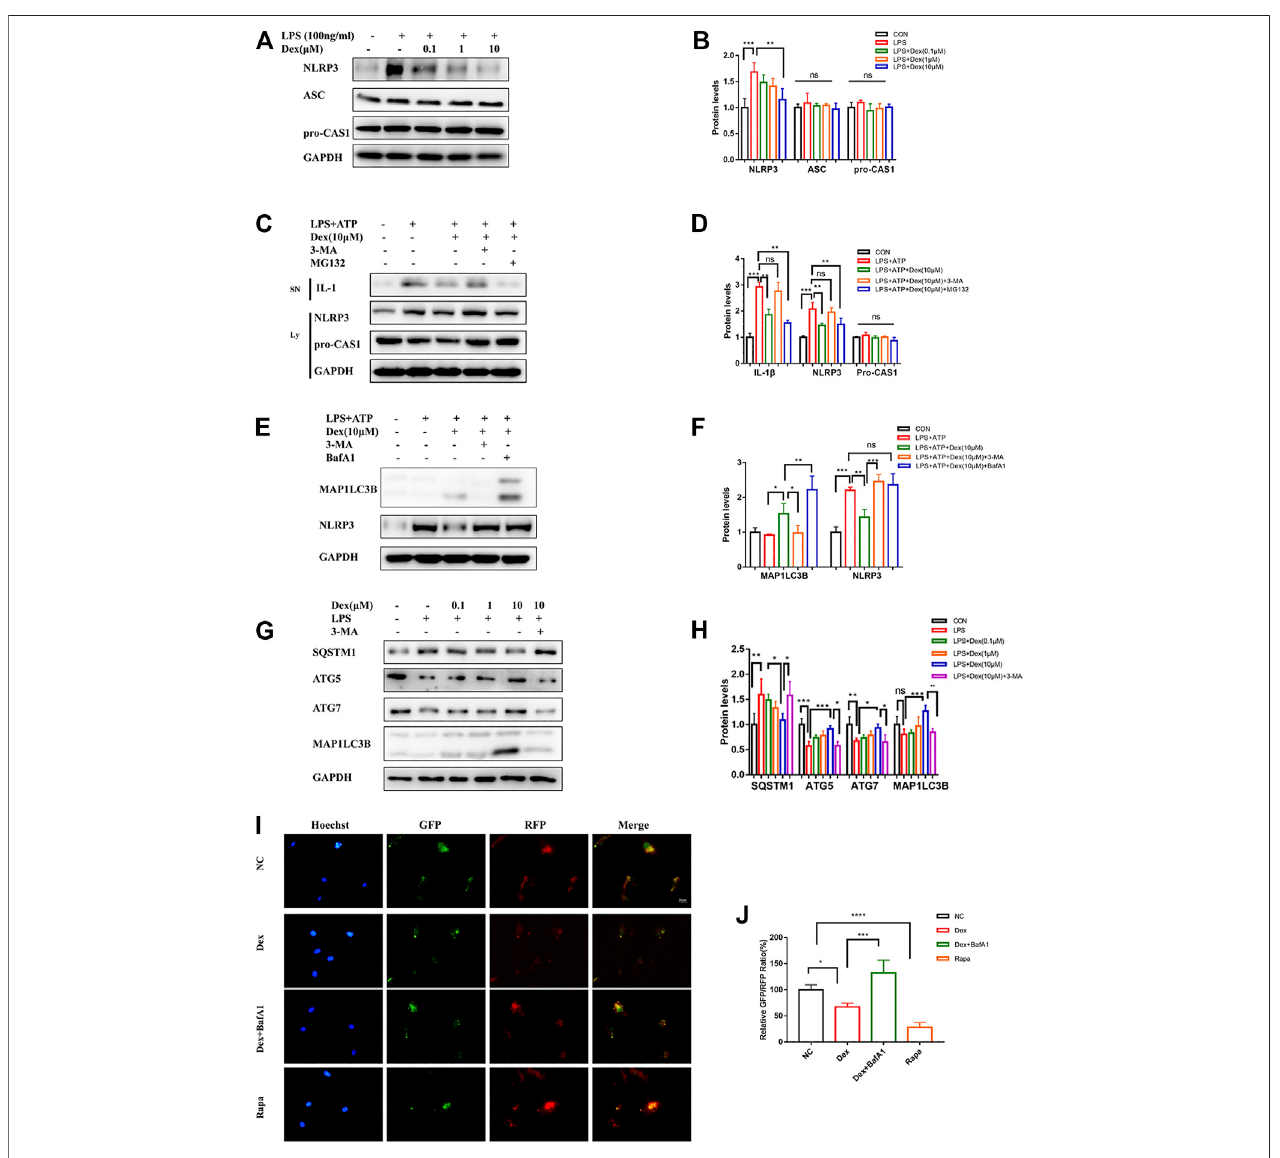
FIGURE 5 | DEX promotes NLRP3 degradation via autophagy pathway. DEX promoted NLRP3 degradation via the autophagy pathway. The cells were treated in the same way as before, and the NLRP3,ASC,pro-CAS1 were detected via Western blot ( A,B , means ± SEM, n (cid:1) 4). LPS-primed primary microglial were cultured